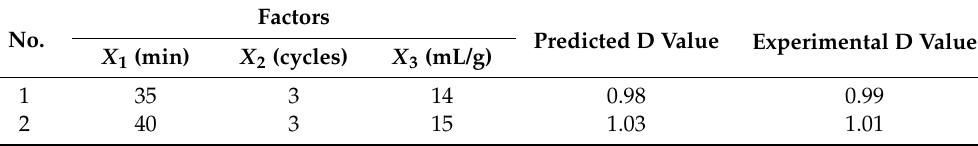
Figure 3. Design space and contour plots: ( a ) extraction cycle ( X 2 ) fixed at 3 cycles; ( b ) extraction time ( X 1 ) fixed at 35 min; ( c ) liquid-to-solid ratio ( X 3 ) fixed at 9 mL/g; ( d ) four-dimensional operation space (D > 0.9). Table 5. Responses for verification experiments.